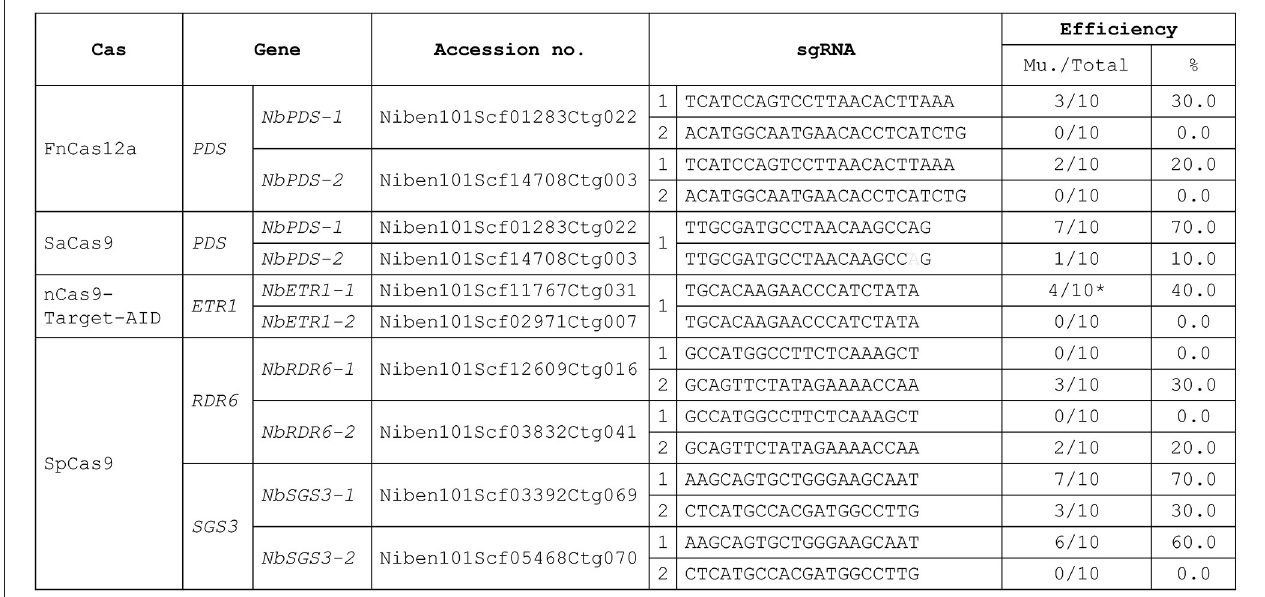
FIGURE 3 | Target mutagenesis efficiencies. Mu, mutants. Gray: sgRNA mismatch. *: mutation. There were 10 regenerated plants (Total) analysis in each transfection. The mutants were confirmed by Sanger sequencing. % = No. of mutants/total no. of regenerated plants analyzed) X 100.